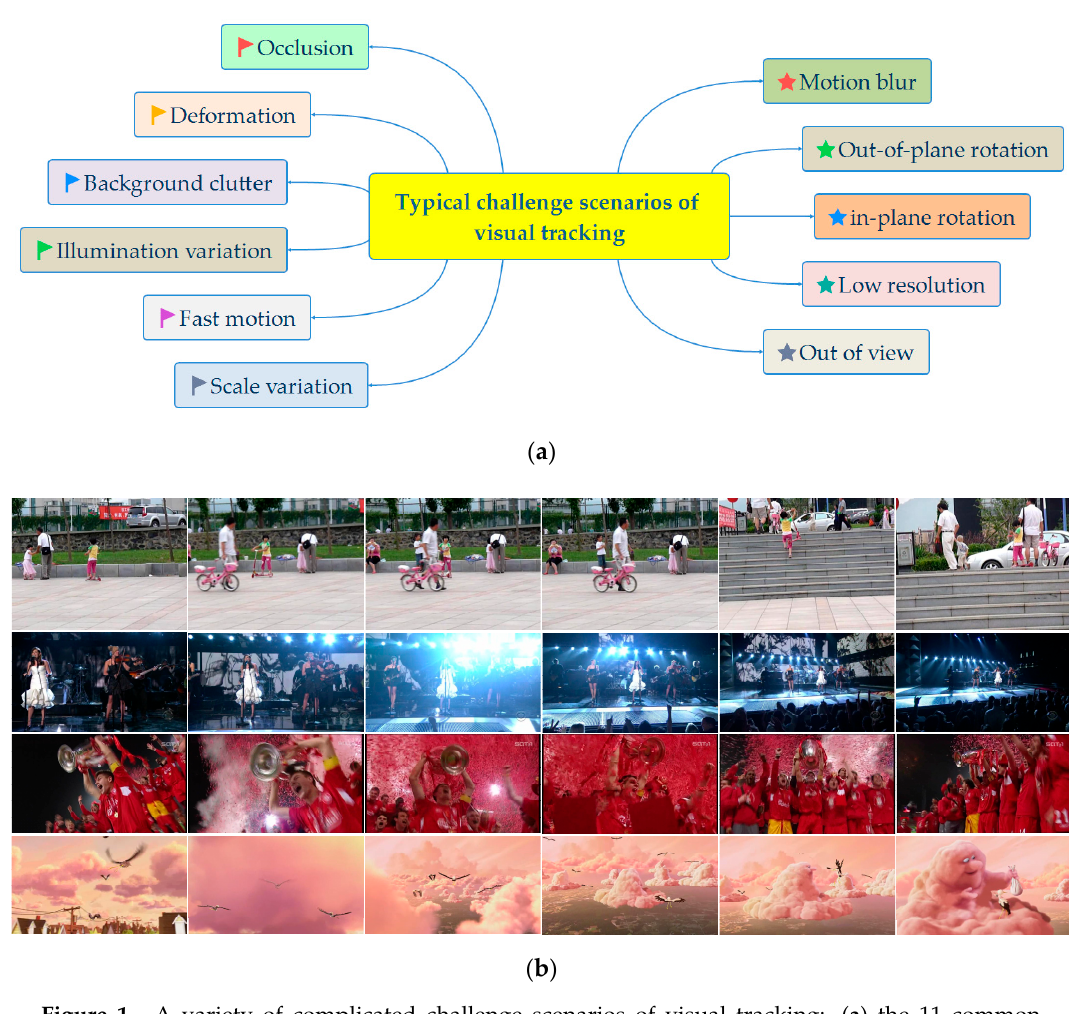
Figure 1. A variety of complicated challenge scenarios of visual tracking: ( a ) the 11 common video challenge scenarios of visual tracking; ( b ) the target objects are in different pose and appearance variations.